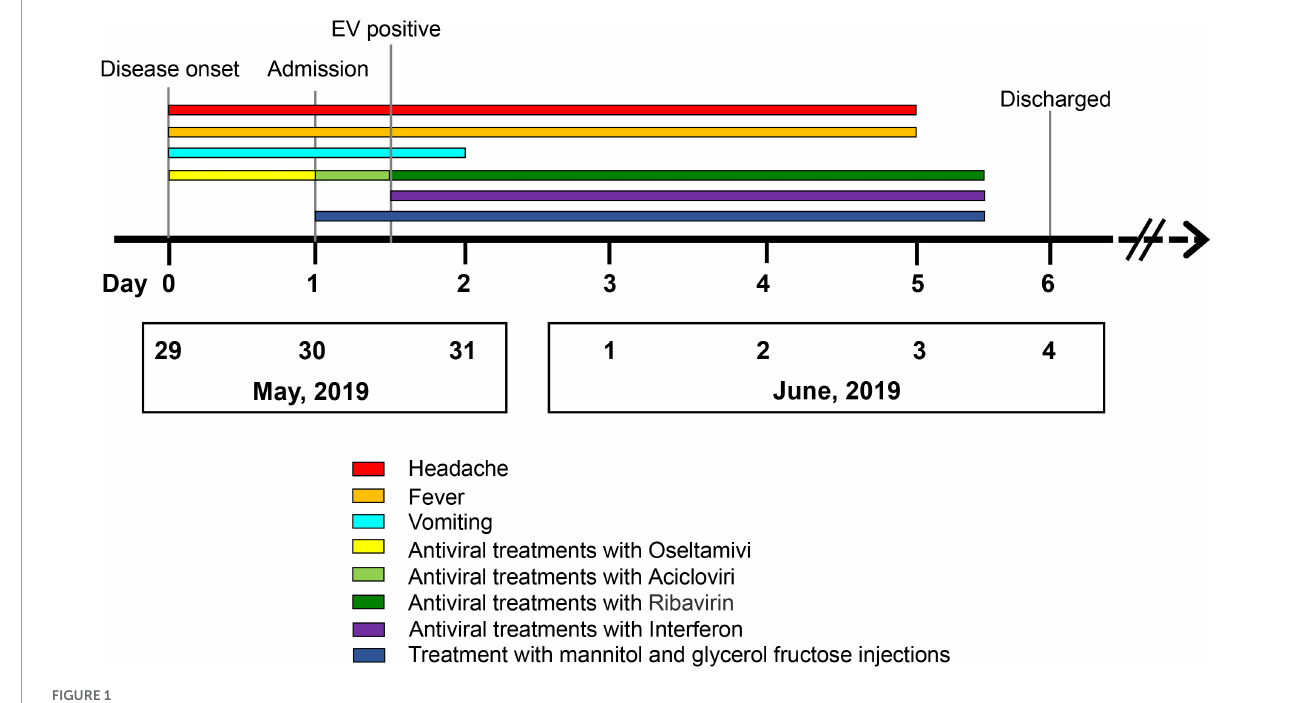
FIGURE1 The timeline of the patients with echovirus 18-induced aseptic